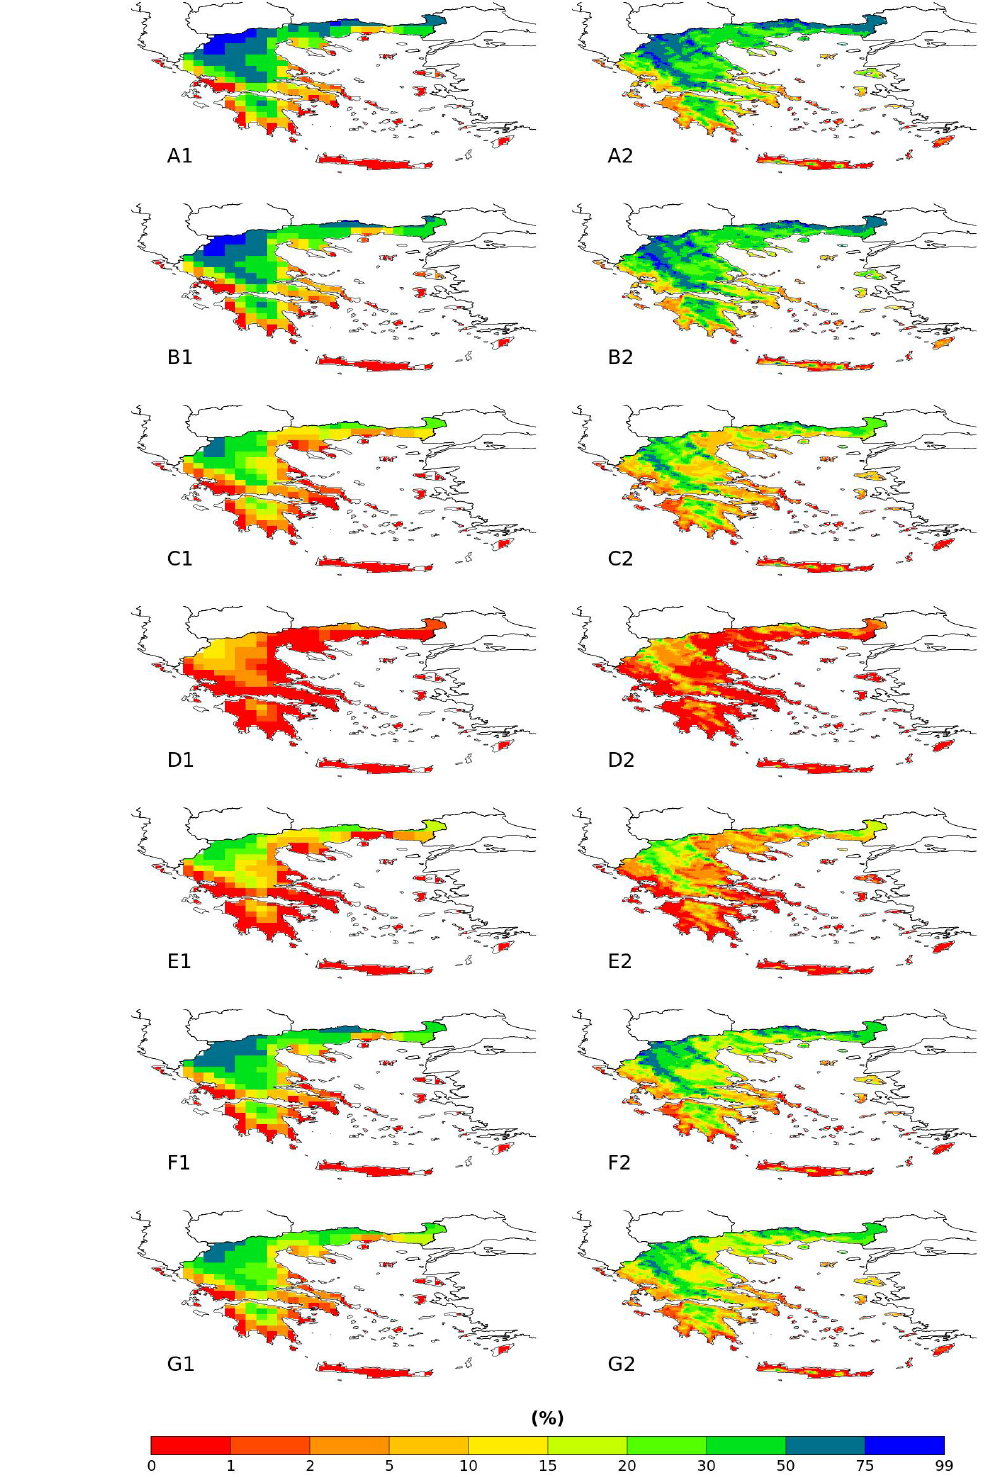
Figure C2. FD probabilities spatial distribution for (1) ERA5 and (2) WRF_5 for the months (a) January, (b) February, (c) March, (d) April, (e) November, (f) December and (g) for the entire season